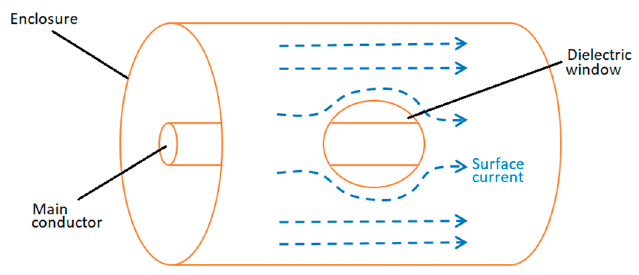
Figure 1. Current deviation around the window.